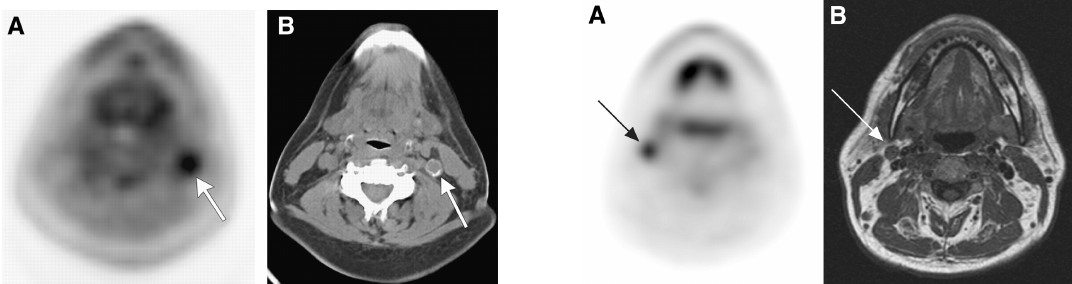
Figure 1. Head–Neck cancer, transverse plane. The arrows indicate the lesions. Left: ( A ) Positron Emission Tomography (PET) ( B ) Computerized Tomography (CT) [12]. Right: ( A ) PET ( B ) T1-weighted Magnetic Resonance Imaging (MRI)